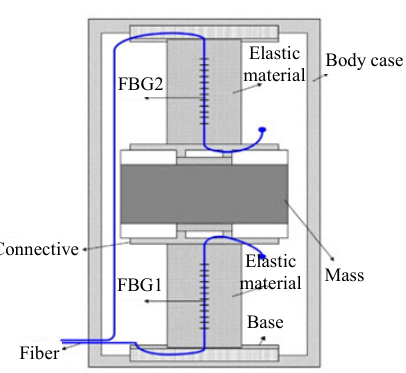
Fig. 12 Schematic of the FBG vibration sensor head.